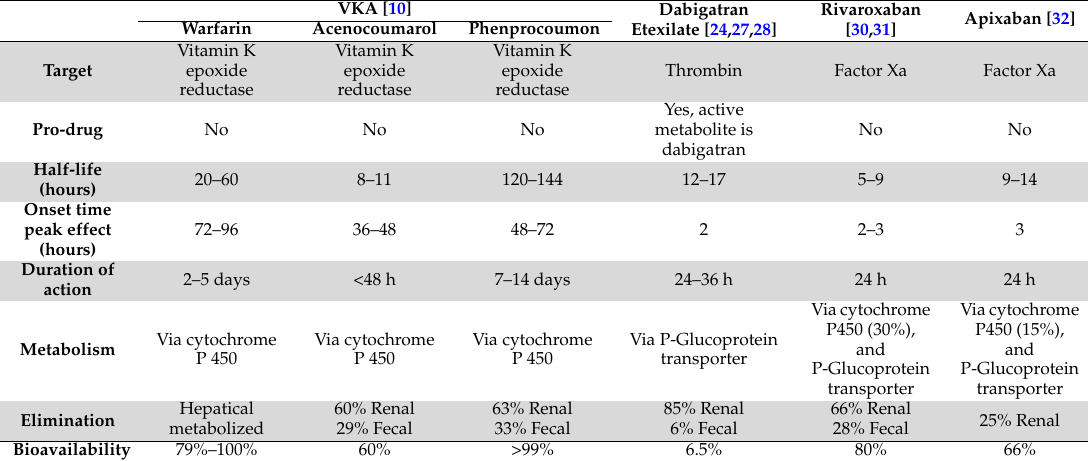
Table 2. Characteristics of VKA and